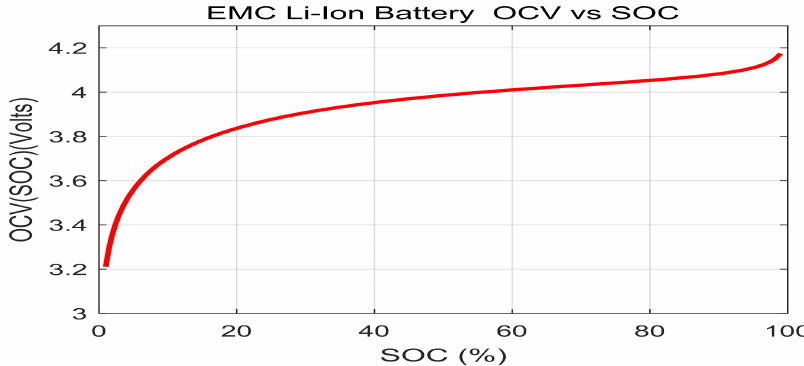
Figure 12. Li-Ion battery OCV versus SOC for a UDDS cycle charging current profile